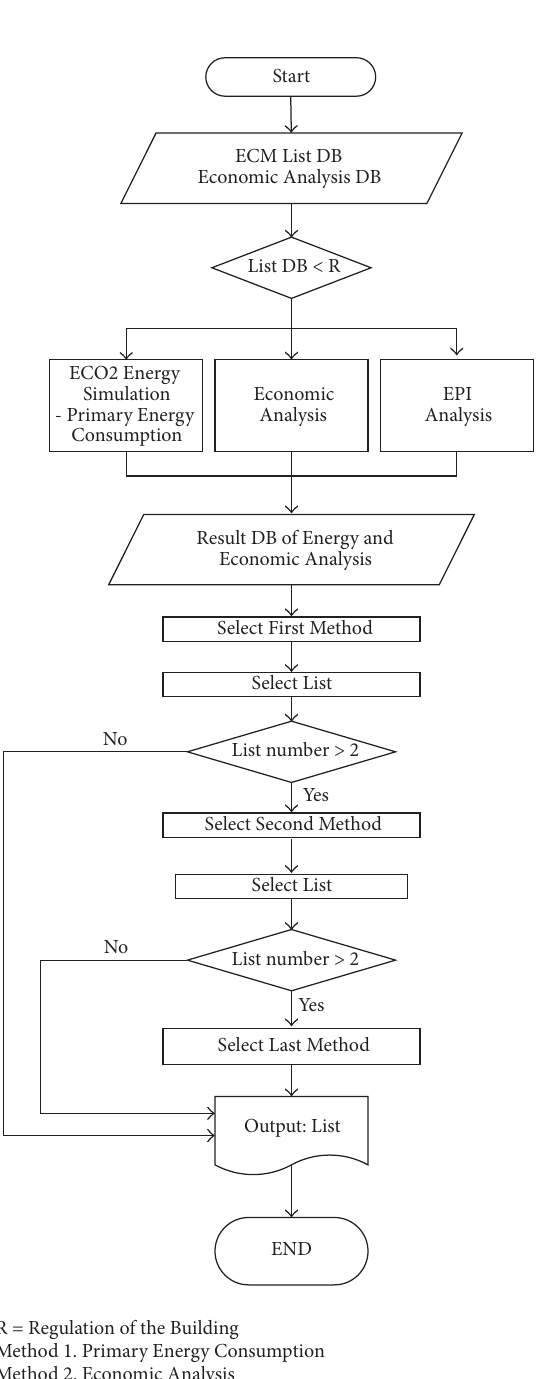
Figure 5: Building Energy Efficiency Decision Support process.